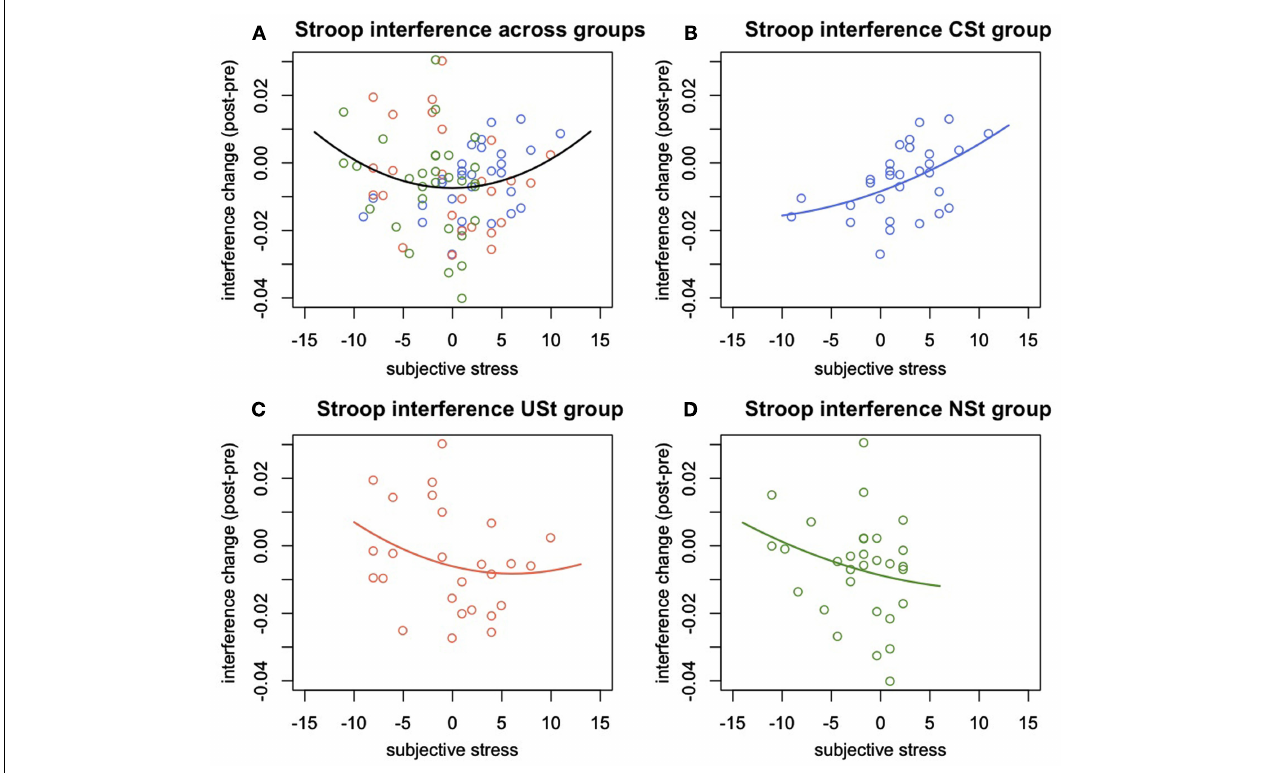
between subjective stress and change in Stroop interference within the group of participants with behavioral control over stressors. (C) Absence of a significant relationship between subjective stress and Stroop interference changes for the group of people exposed to uncontrollable stress, or (D) to